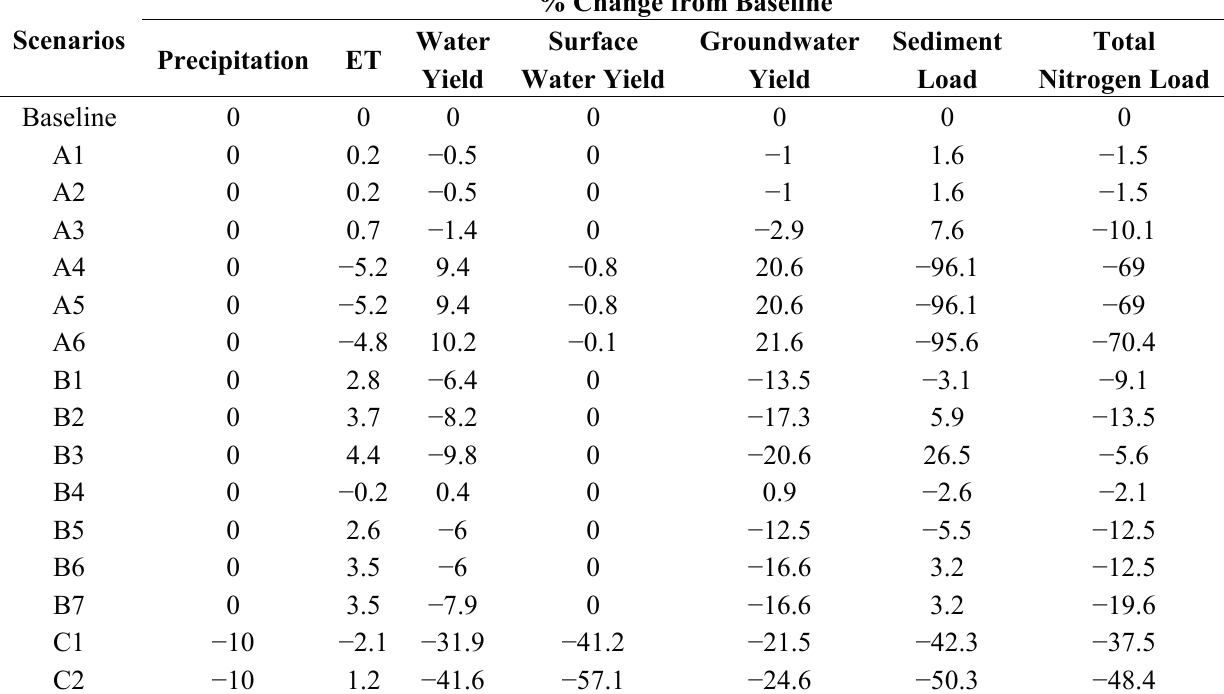
Table 3. Percent changes in Water Yield, ET, Sediment Yield and Total Nitrogen Load under different